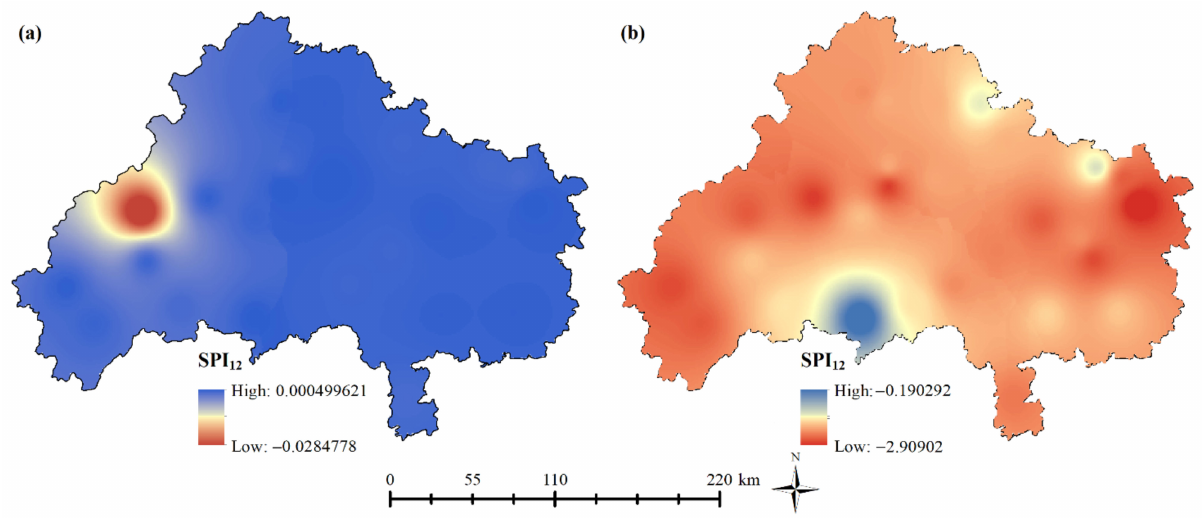
Figure 8. Spatial patterns of SPI 12 in HSDC. ( a ) Year with normal climate; and ( b ) climatic drought